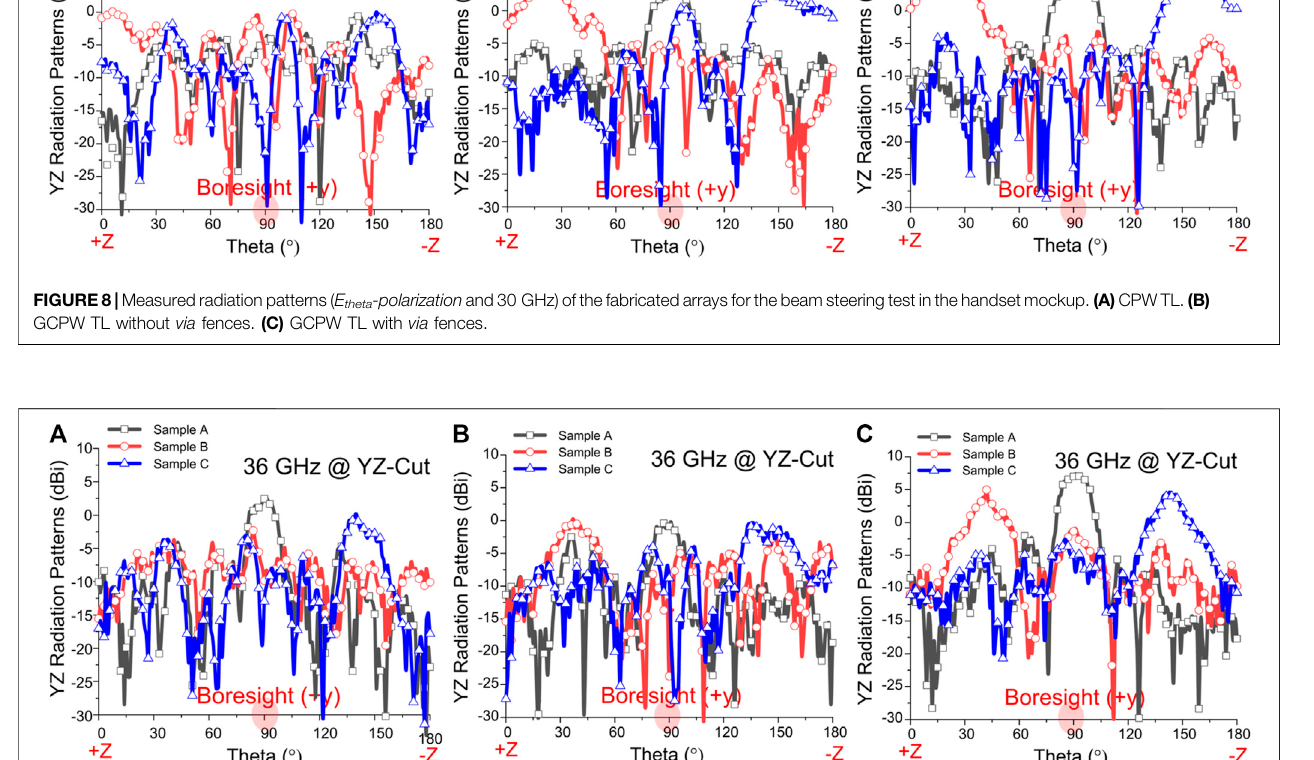
Frontiers in Communications and Networks |